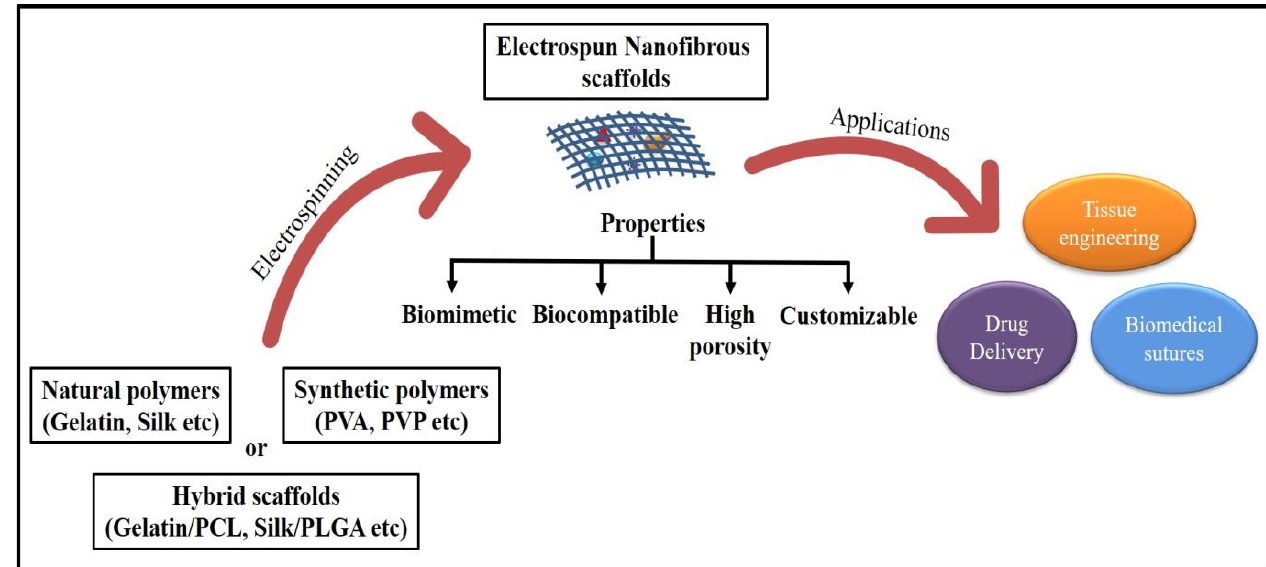
Figure 2. Electrospun nanofibrous scaffolds for biomedical applications.